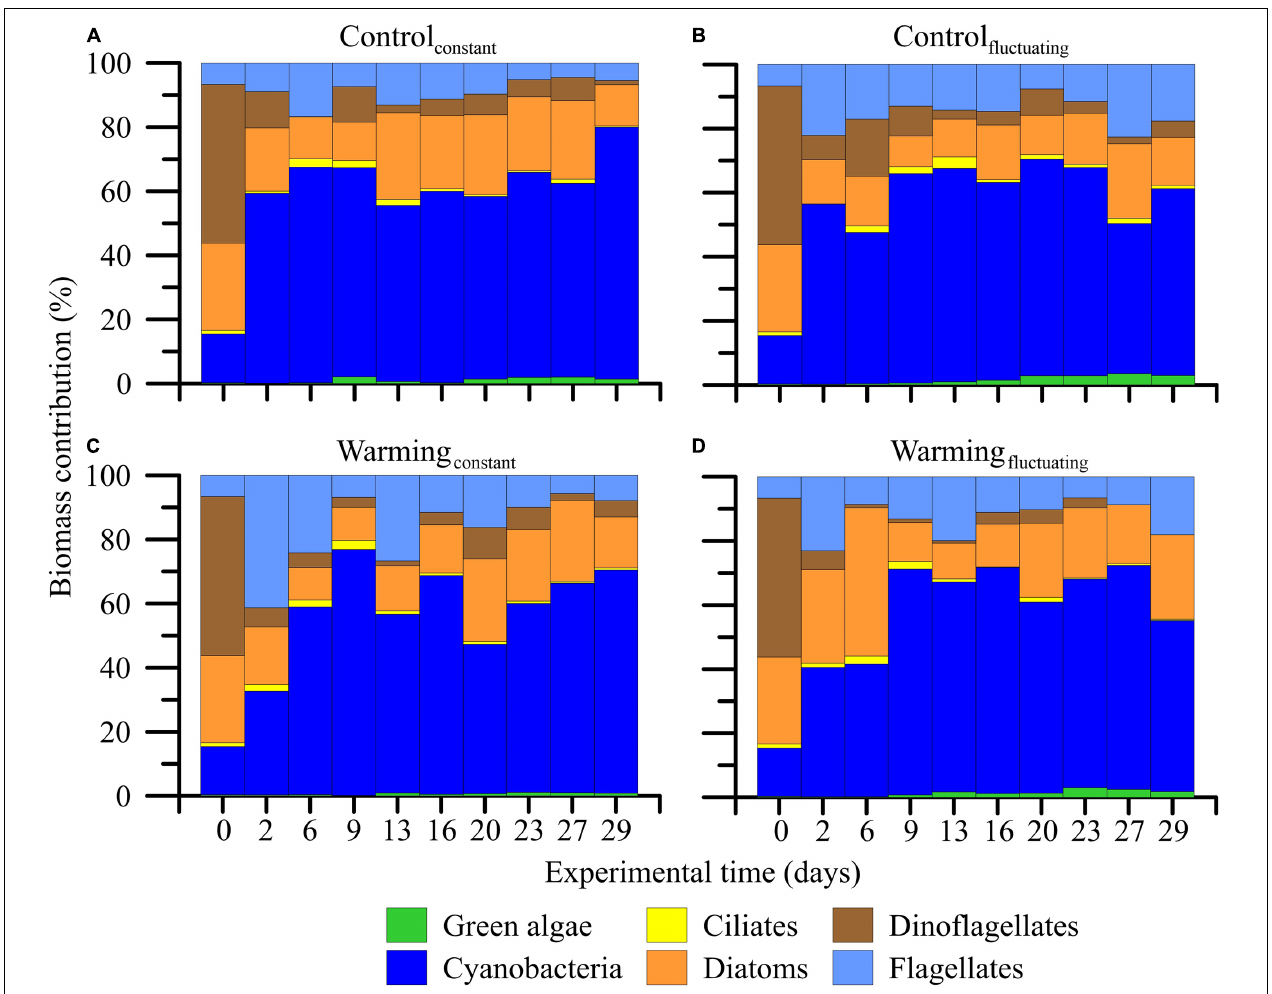
FIGURE 3 | (A–D) Contribution of the microbial plankton groups to the total community biomass (%) when exposed to two temperature treatments [Control (15 ◦ C) and Warming (18 ◦ C)] and regimes [Constant and Fluctuating ( ± 3 ◦ C respect to Present and Future)] over the experimental